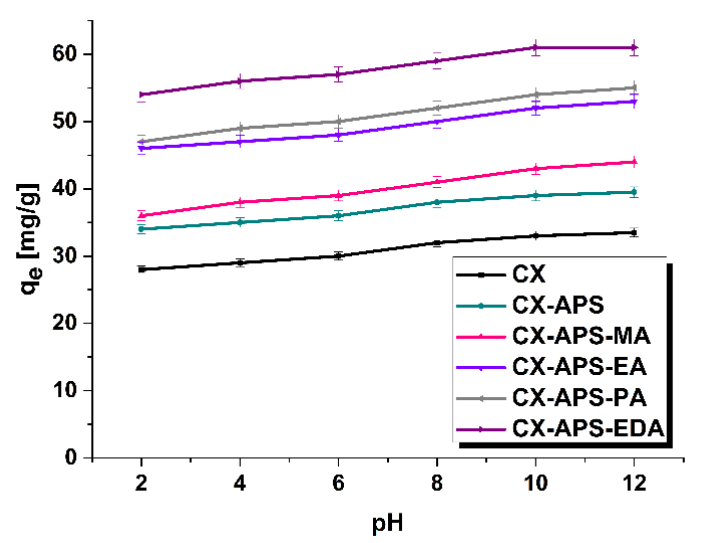
Figure 7. The influence of pH on the adsorption of thymol blue (adsorbent mass, 20 mg; initial dye solution concentration, 80 mg/L; volume of dye solution, 80 mL; temperature, 22 ± 1 °C).